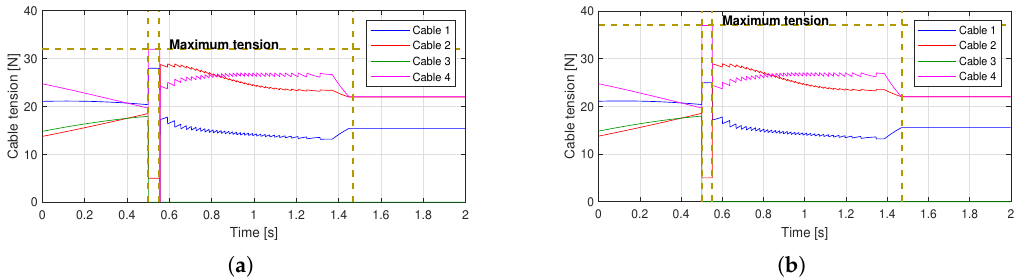
Figure 14. Cable tensions behaviour for different τ max limits. Cable 1 is represented in blue, cable 2 in red, cable 3 in green and cable 4 in violet. ( a ) Cable tensions for τ max = 32 N; ( b ) Cable tensions for τ max = 37 N.